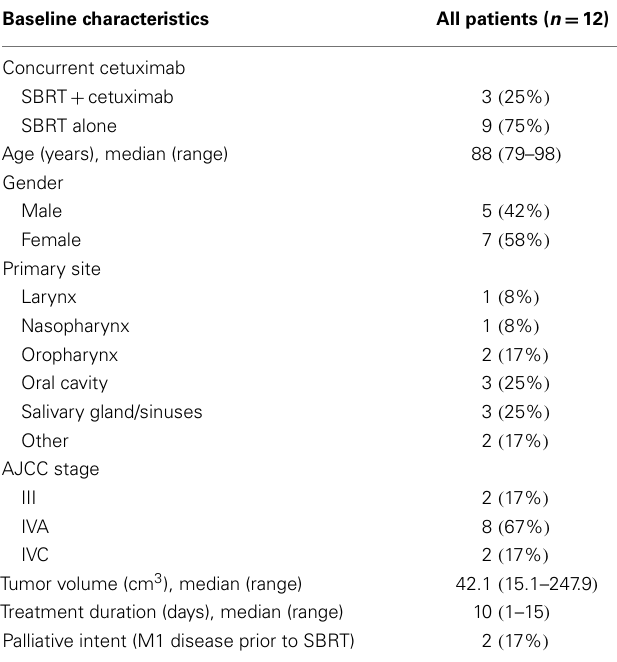
Table 1 | Baseline patient characteristics